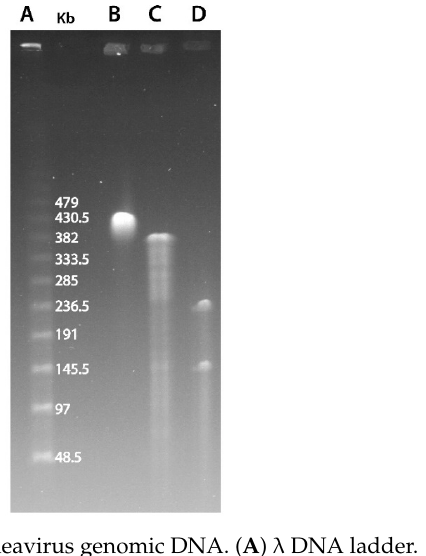
Figure 1. PFGE resolution of noumeavirus genomic DNA. ( A ) λ DNA ladder. ( B ) Undigested